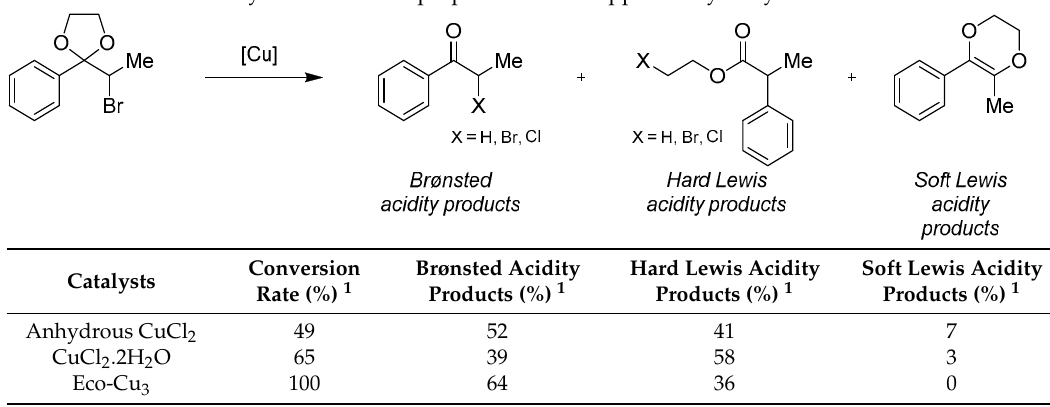
Table 5. The analysis of the acidic properties of the copper catalysts by Corma’s method.